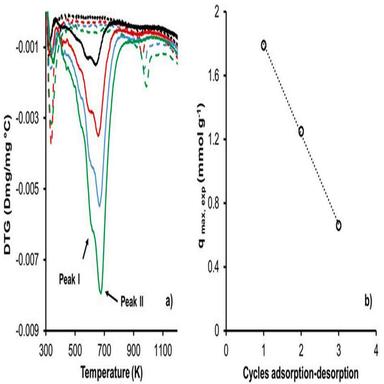
(a) DTG profiles of BioC (dotted line) and BioC-saturated with Atenolol 120 mg L− 1 (solid line), obtained at different heating rates: 10 K min− 1 (black), 20 K min− 1 (red), 30 K min− 1 (blue) y 40 K min− 1 (green). (b) Atenolol adsorption capacities onto BioC in repeated adsorption-desorption cycles. (For interpretation of the references to colour in this figure legend, the reader is referred to the web version of this article.)